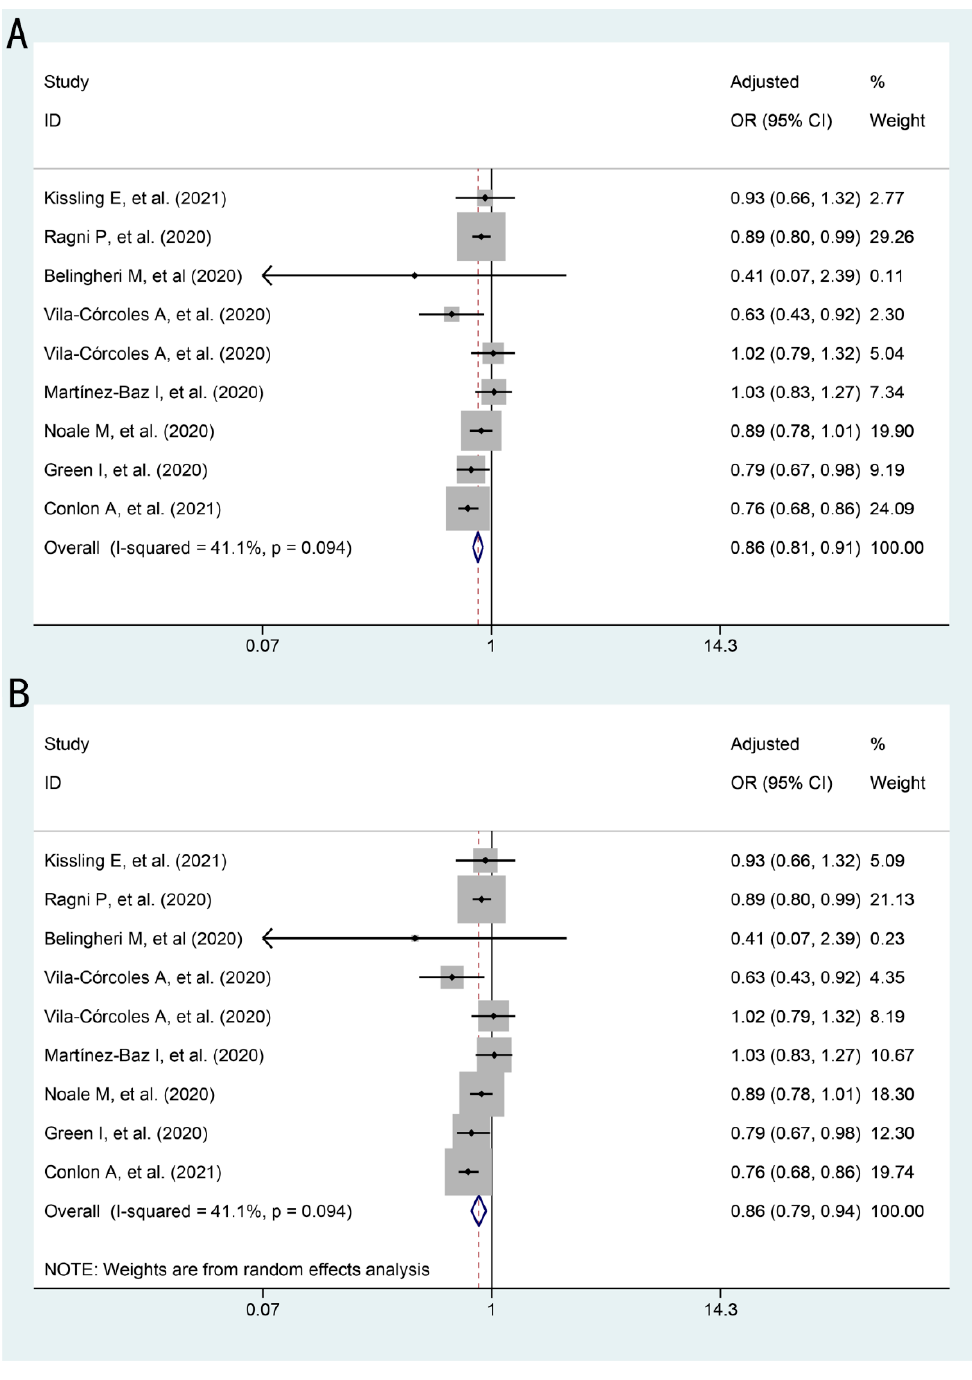
Figure 2. Forest plots for the association between influenza vaccination and SARS-CoV-2 infection: ( A ) adjusted OR by fixed effects model ( B ) adjusted OR by random effects model. Table 3. Summary of the overall association between influenza vaccination and SARS-CoV-2 infection and clinical outcomes.